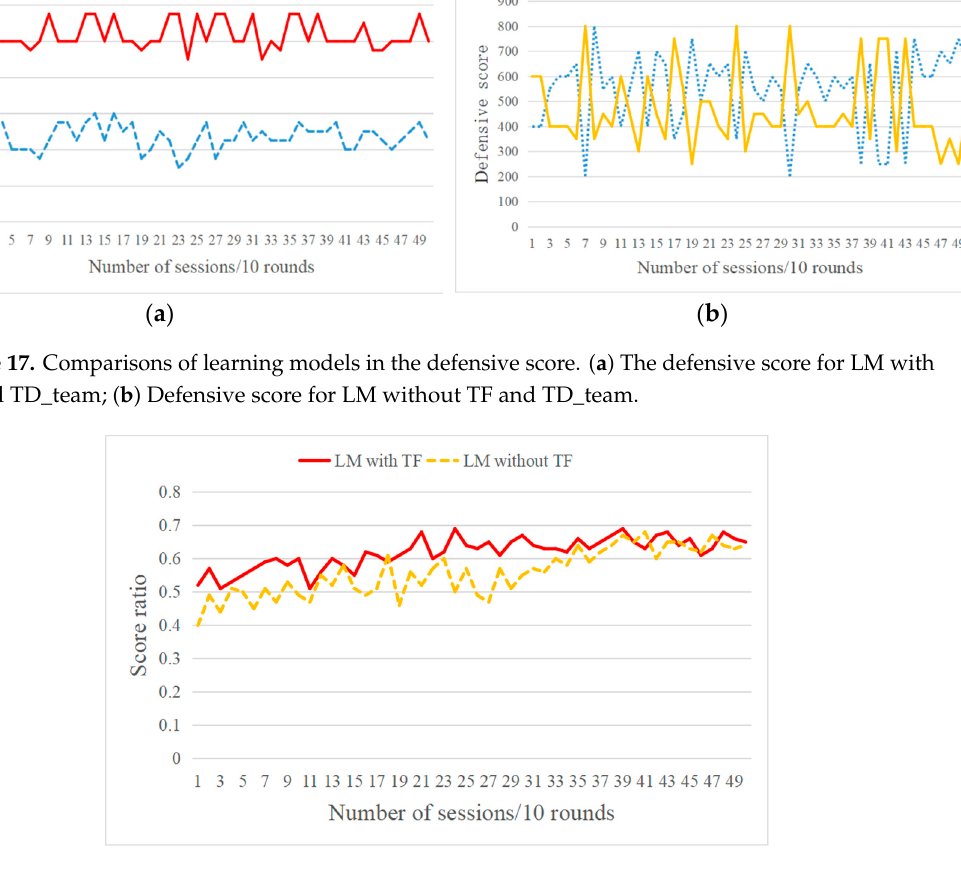
Figure 18. Comparisons of learning models in score ratio.